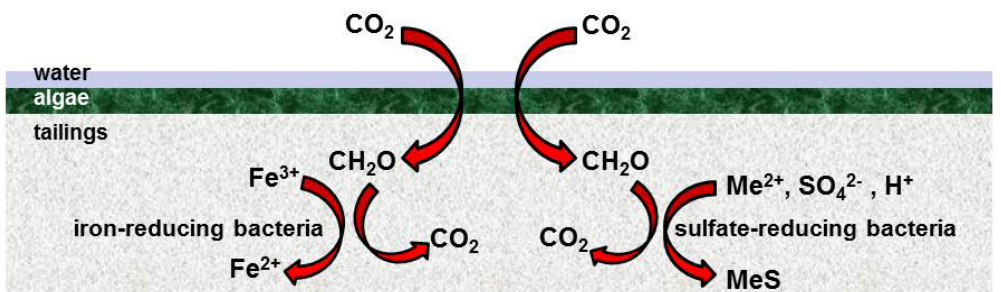
Figure 3. Schematic representation of an ecological engineering strategy for securing reactive mine tailings [21]. Freshly-deposited tailings are inoculated with acidophilic algae and heterotrophic bacteria. The algae grow as a surface layer on the tailings in the pond, fixing carbon and providing organic carbon (CH O) which sustains the growth of iron- and 2 sulfate-reducing bacteria within the submerged tailings, thereby essentially reversing the reactions that generate AMD. Additional protection of the minerals may be mediated by “bioshrouding” by the heterotrophic acidophiles